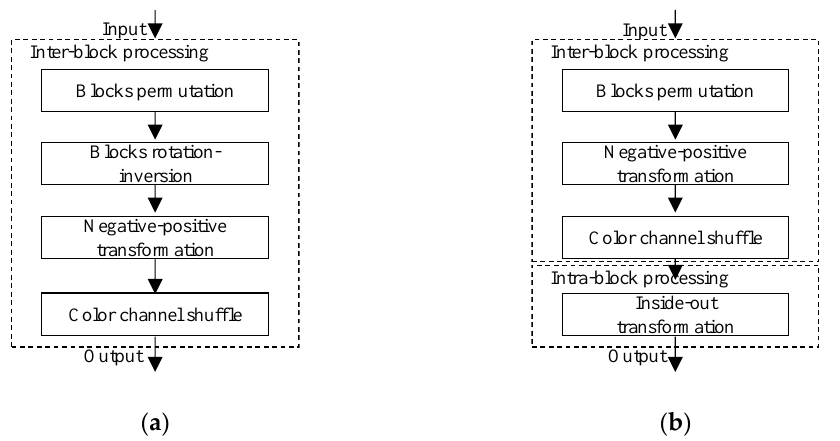
Figure 1. Block-based perceptual encryption algorithms. ( a ) The conventional perceptual encryption scheme. ( b ) The proposed inter and intra block processing-based perceptual encryption